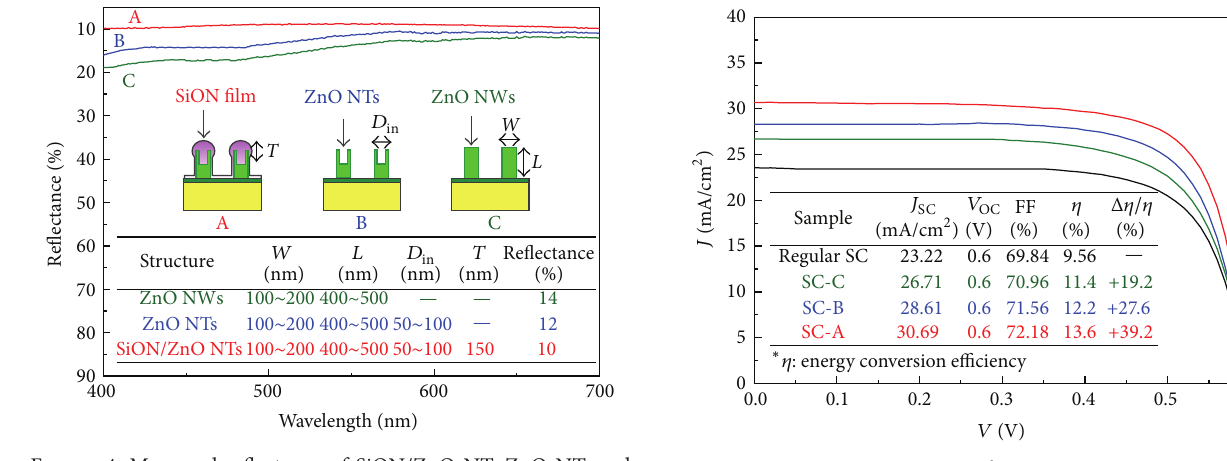
Figure 4: Measured reflectance of SiON/ZnO NT, ZnO NT, and NW arrays on ZnO (seed layer)/glass substrate. Thickness of ZnO seed layer is 10 nm.